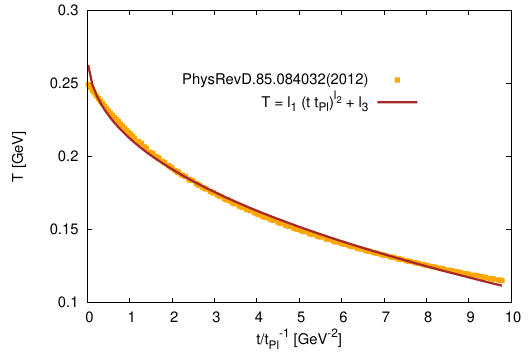
Figure 8. Time dependence of the temperature T , at the bag constant B 1/4 = 200 MeV, on time t . The symbols refer to the results.